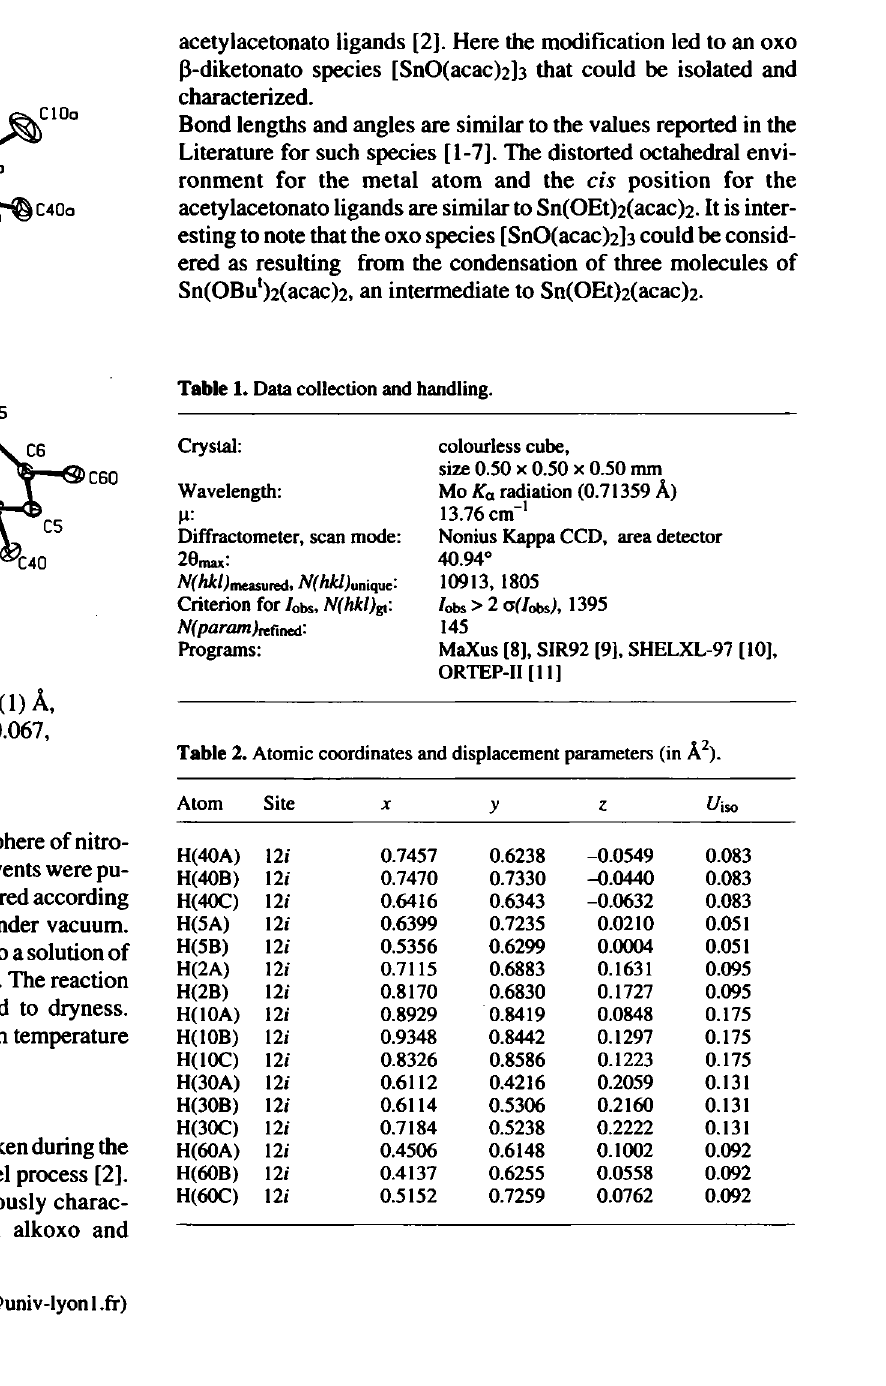
Table 1. Data collection and handling.